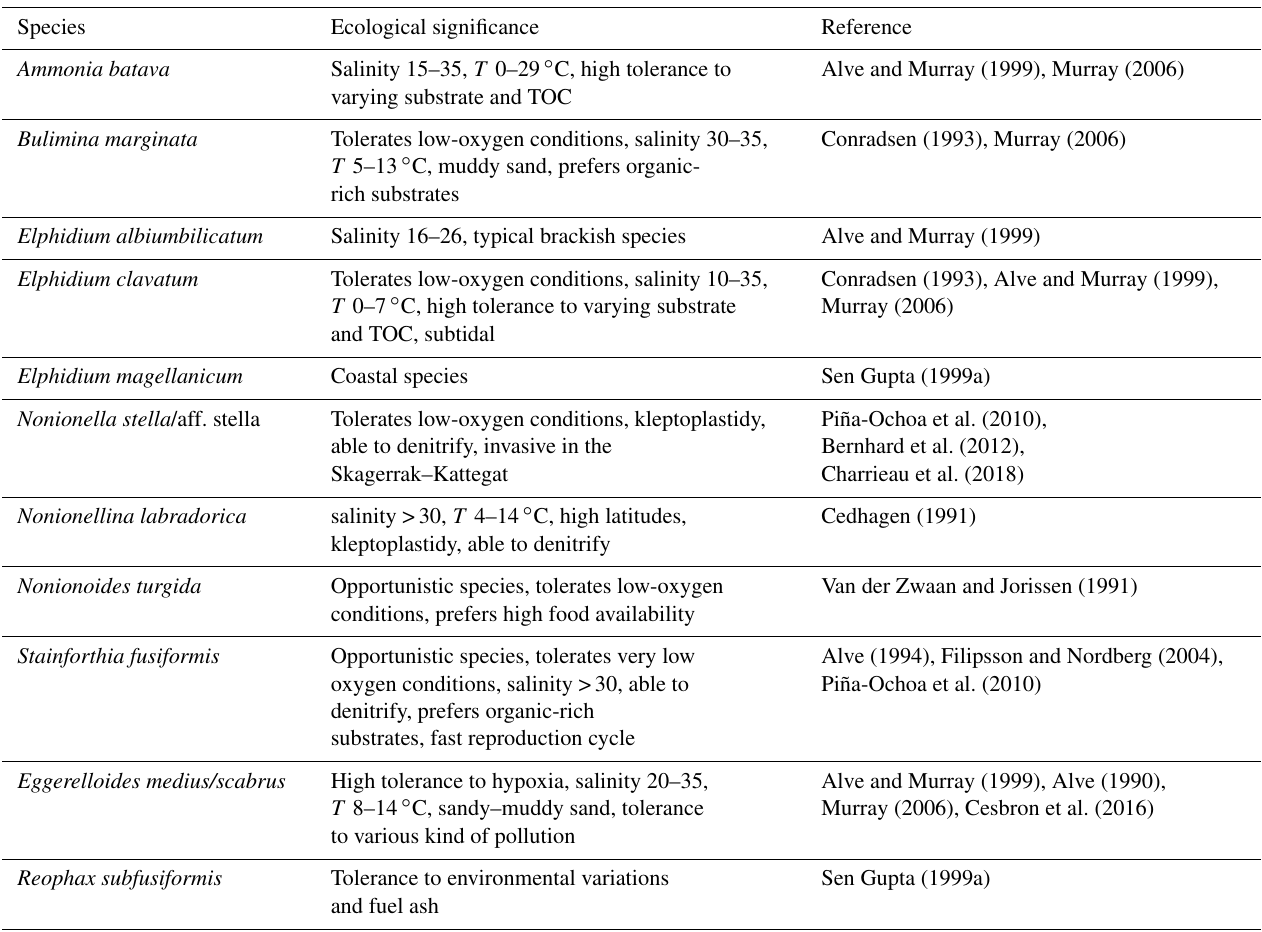
Table 2. Ecological significance of the benthic foraminiferal assemblages (major species).